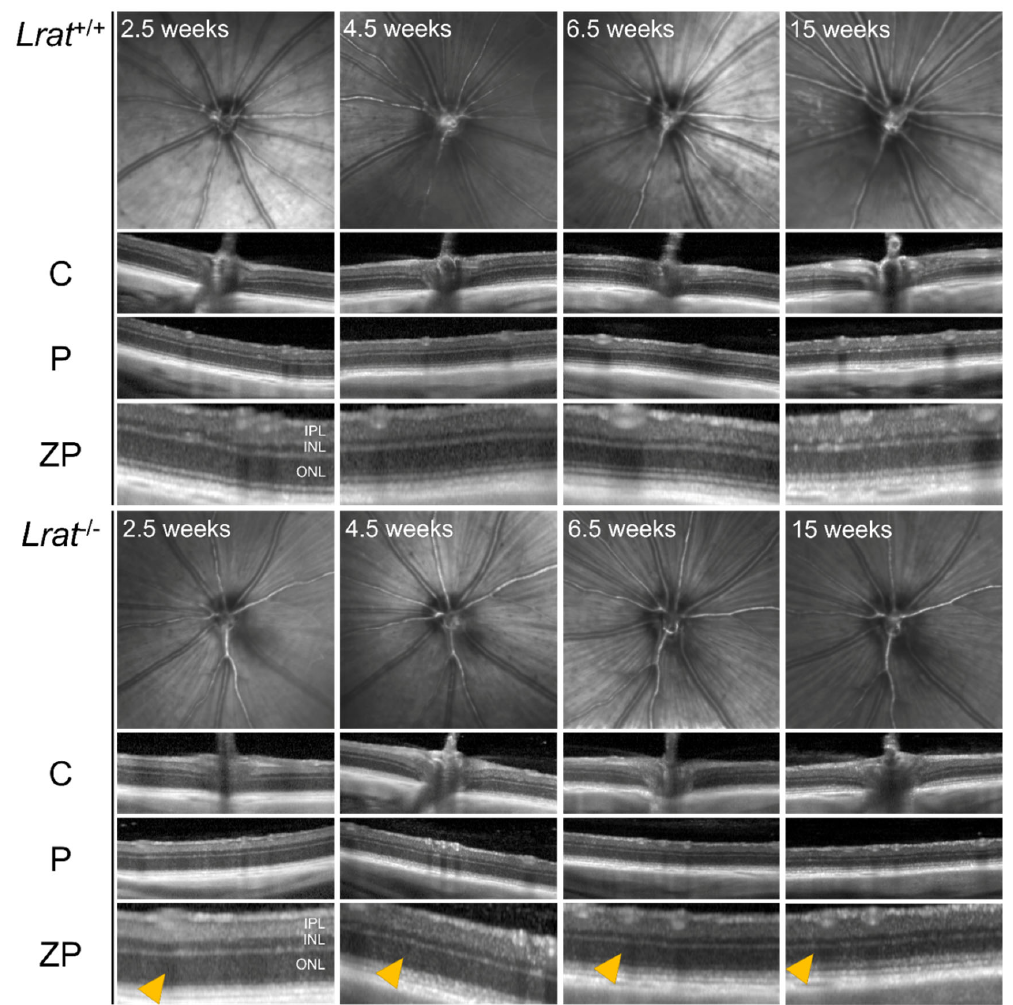
Figure 5. Representative qualitative SLO and OCT images of Lrat +/+ and Lrat − / − rats at different ages. OCT scans from the same eye of the central area (C), including the optic disc and the peripheral area (P), are included for each genotype. Additionally, a more detailed image of the peripheral area is shown (ZP). It is possible to identify all retinal layers, including the inner plexiform layer (IPL), the inner nuclear layer (INL), and the outer nuclear layer (ONL) in both the wildtype and knockout animals from the OCT images. The layering of the retina becomes less distinct in the knockout animals over time. The retina of knockout animals degenerates over time and becomes thinner at later stages. Especially the ONL layer, representing the cell bodies of the PRs, becomes thinner over time (yellow arrows). For the thickness quantification, see Figure 6. No differences can be observed between wildtype and knockout SLO images.